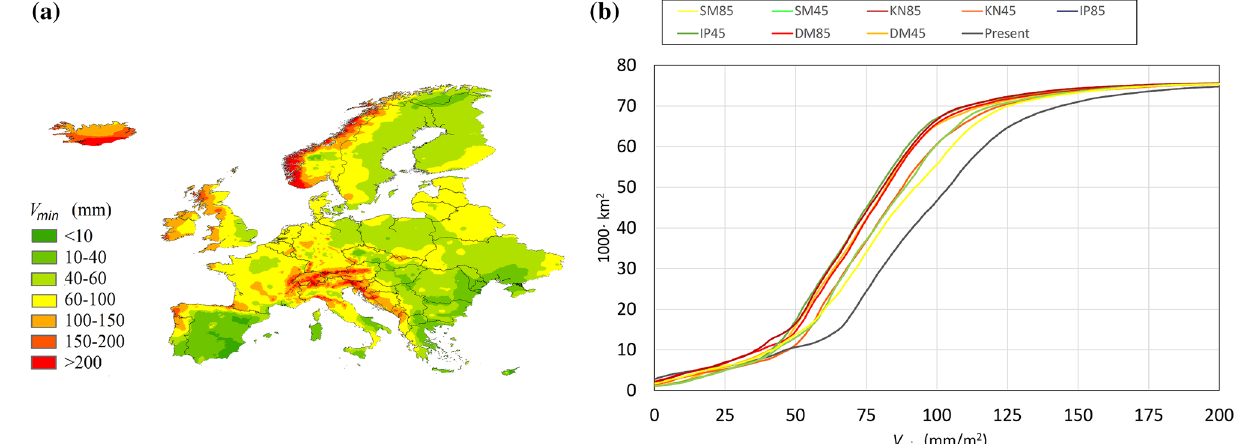
Figure 3. Storage volume V min required to store the runoff in the case of constant demand.